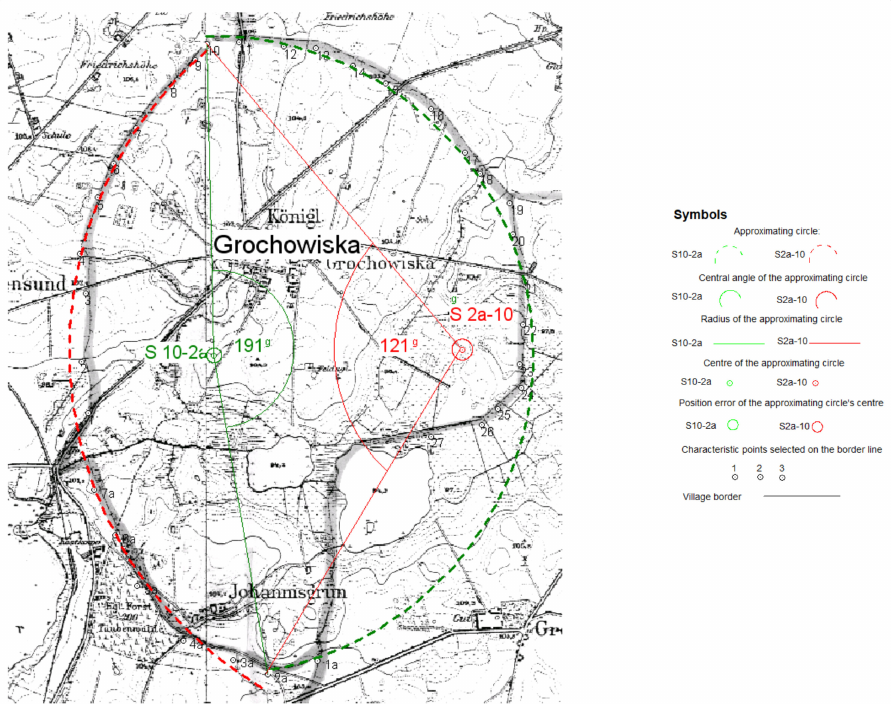
Figure 16. Grochowiska. Course, position and error of the approximating circle: S 10—2a— approximation of points 10—2a, S 2a—-10—approximation of points 2a-10. Scale 1:50,000.